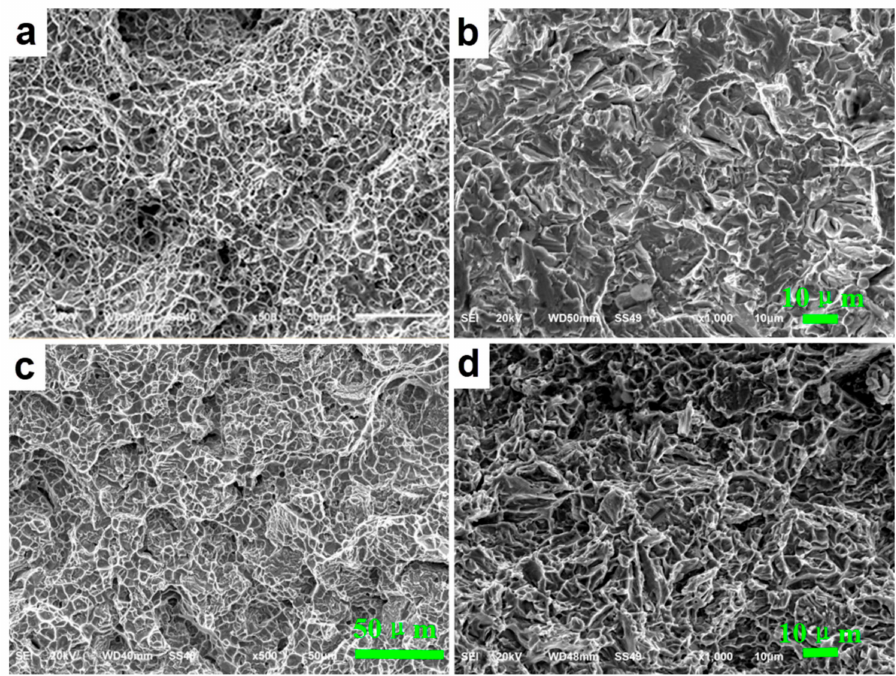
Figure 12. SEM images for tensile fracture morphology of Inconel 783 alloy bolts after aging at 650 ◦ C for 1000 h ( a ), 20,000 h ( b ), and 700 ◦ C for 1000 h ( c ), 20,000 h ( d